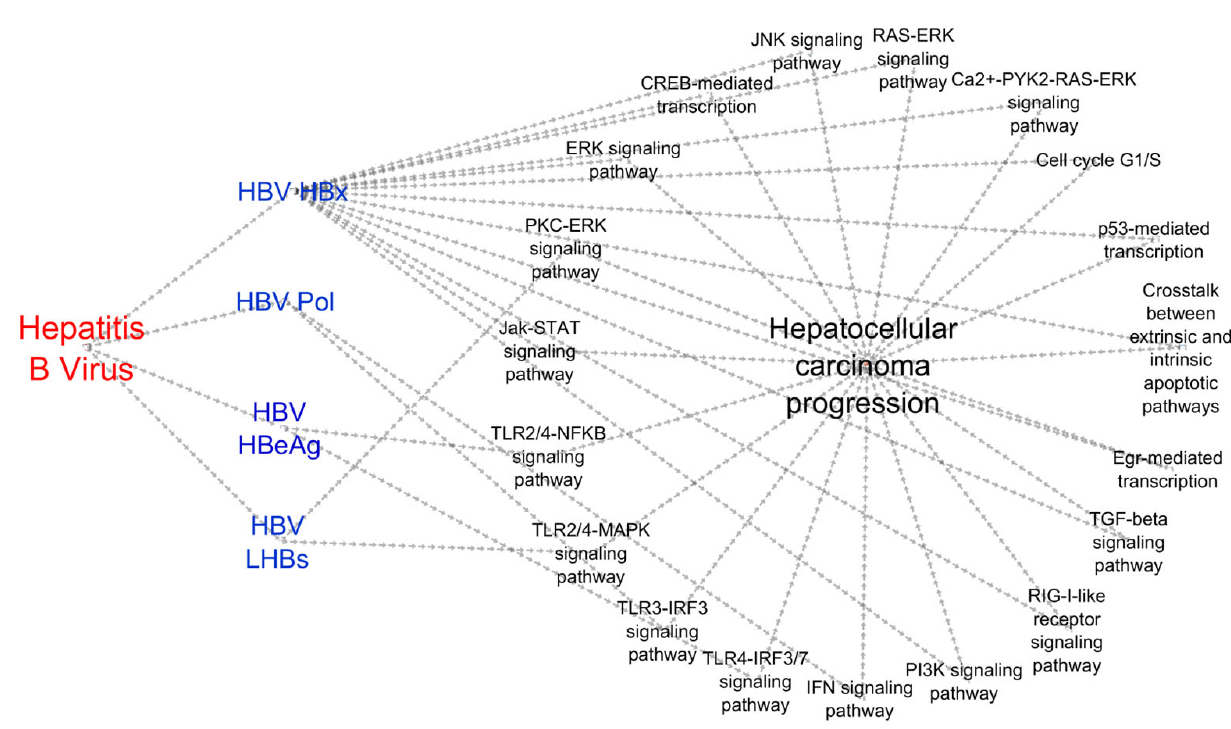
Figure 2. Network representation of pathways involved in HBV infection ‐ induced HCC.